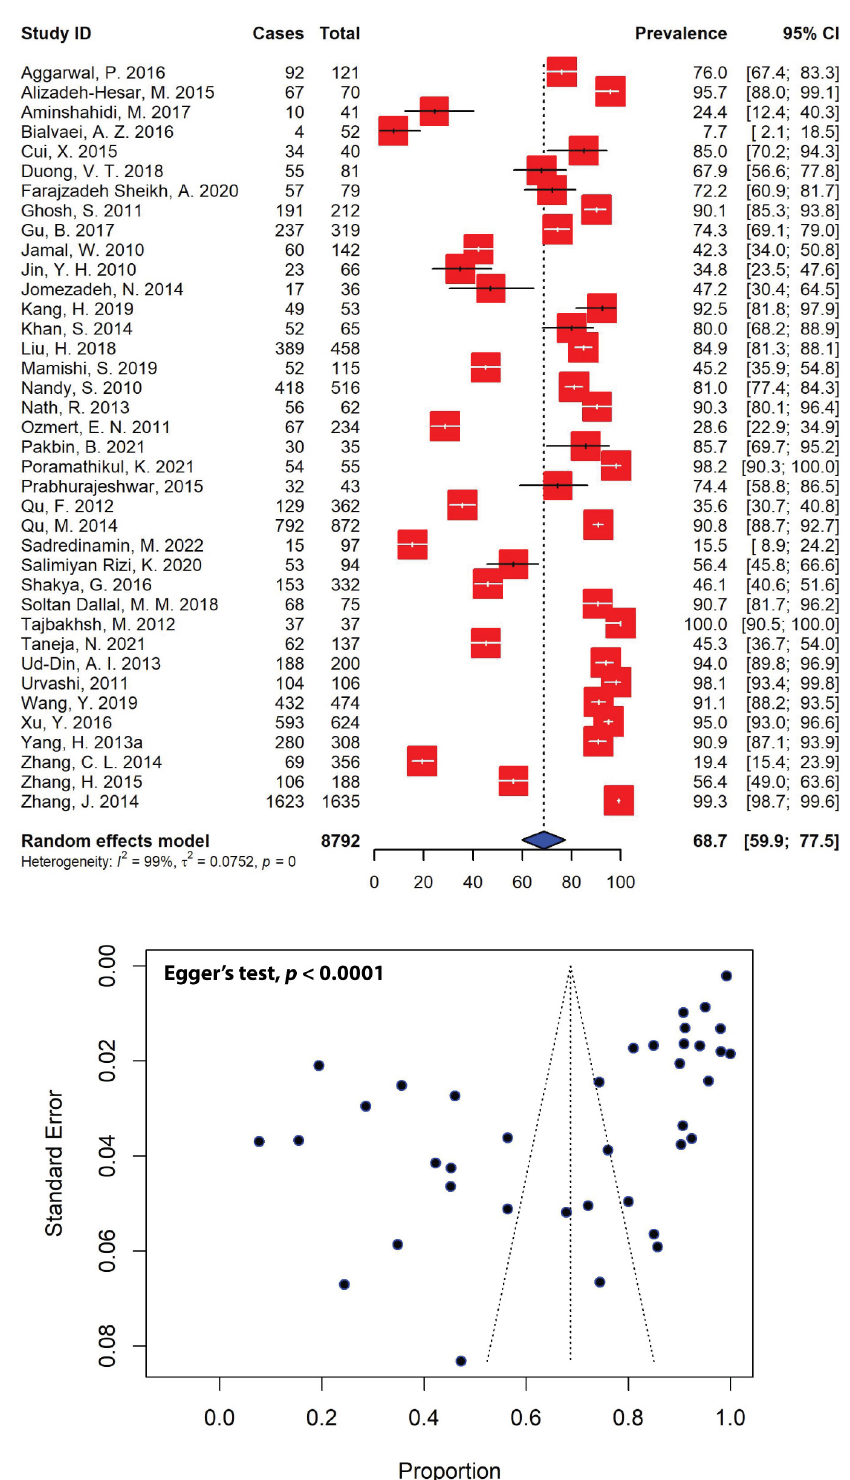
Figure 5. Forest and funnel plots representing the pooled prevalence of multidrug-resistant Shigella spp. in Asia. The estimate of prevalence was calculated by pooling 38 selected studies using the random-effects model ( top panel ). The distribution of effect estimates is shown by a funnel plot ( bottom panel ). Figures were generated using RStudio software. Table 4. Pooled prevalence of multidrug-resistant Shigella in different Asian regions.